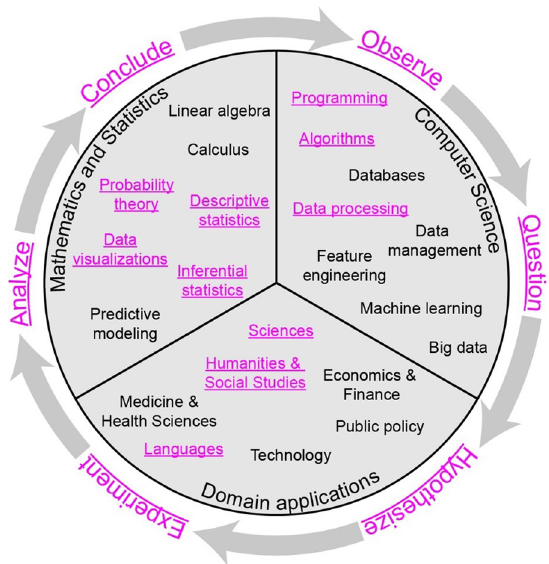
Fig. 1 Data science as an interdisciplinary field. Our framework of data science as an amalgamation of mathematics, statistics, and computer science with specific domain applications. Overlaid are iterative scientific processes that support data science. Underlined in magenta, components of data science formally incorporated in the curriculum of many elementary and secondary school